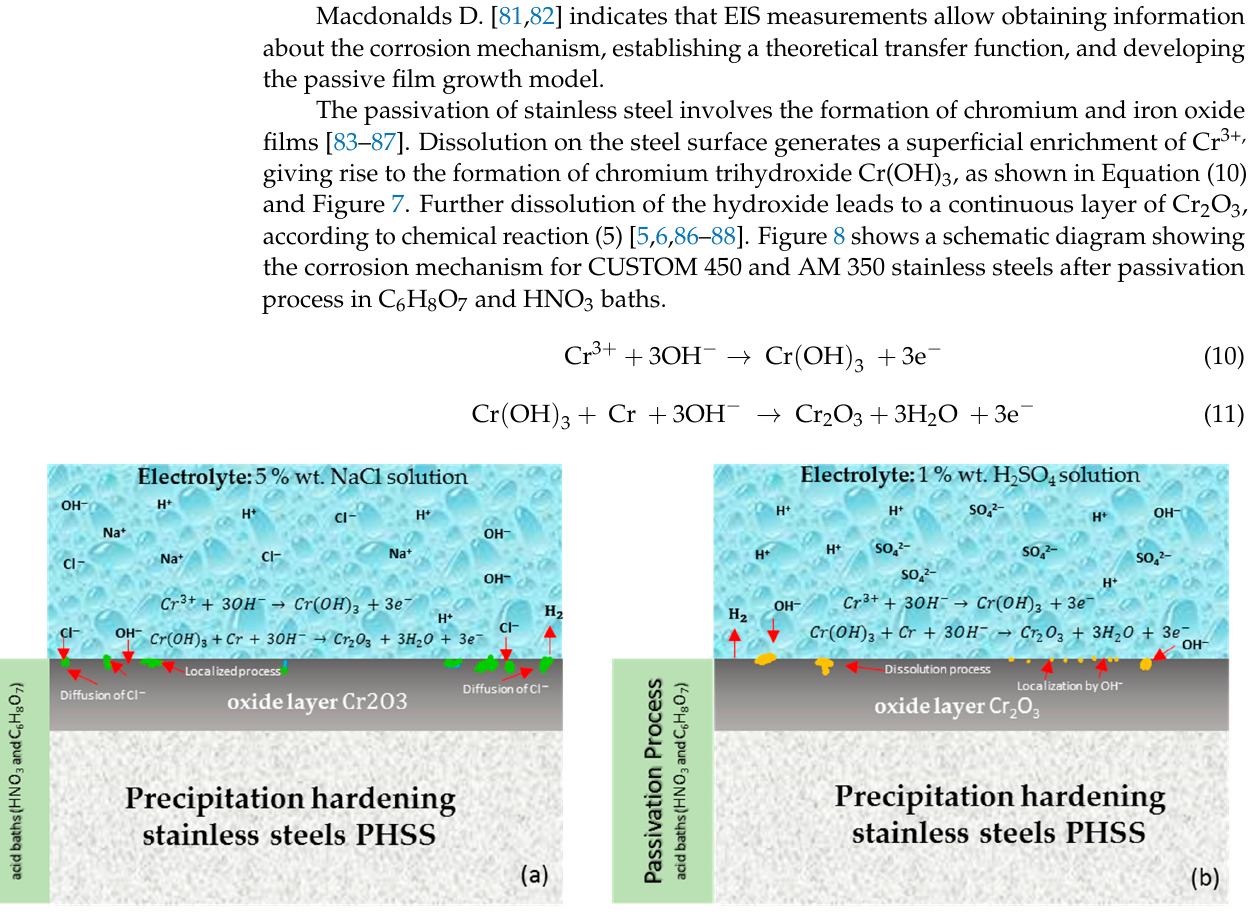
Figure 8. Schematic diagram of passivation process in C 6 H 8 O 7 and HNO 3 bath for CUSTOM 450 and AM 350 stainless steels exposed to ( a ) 5 wt. % NaCl solution; ( b ) 1 wt. % H 2 SO 4 solution.